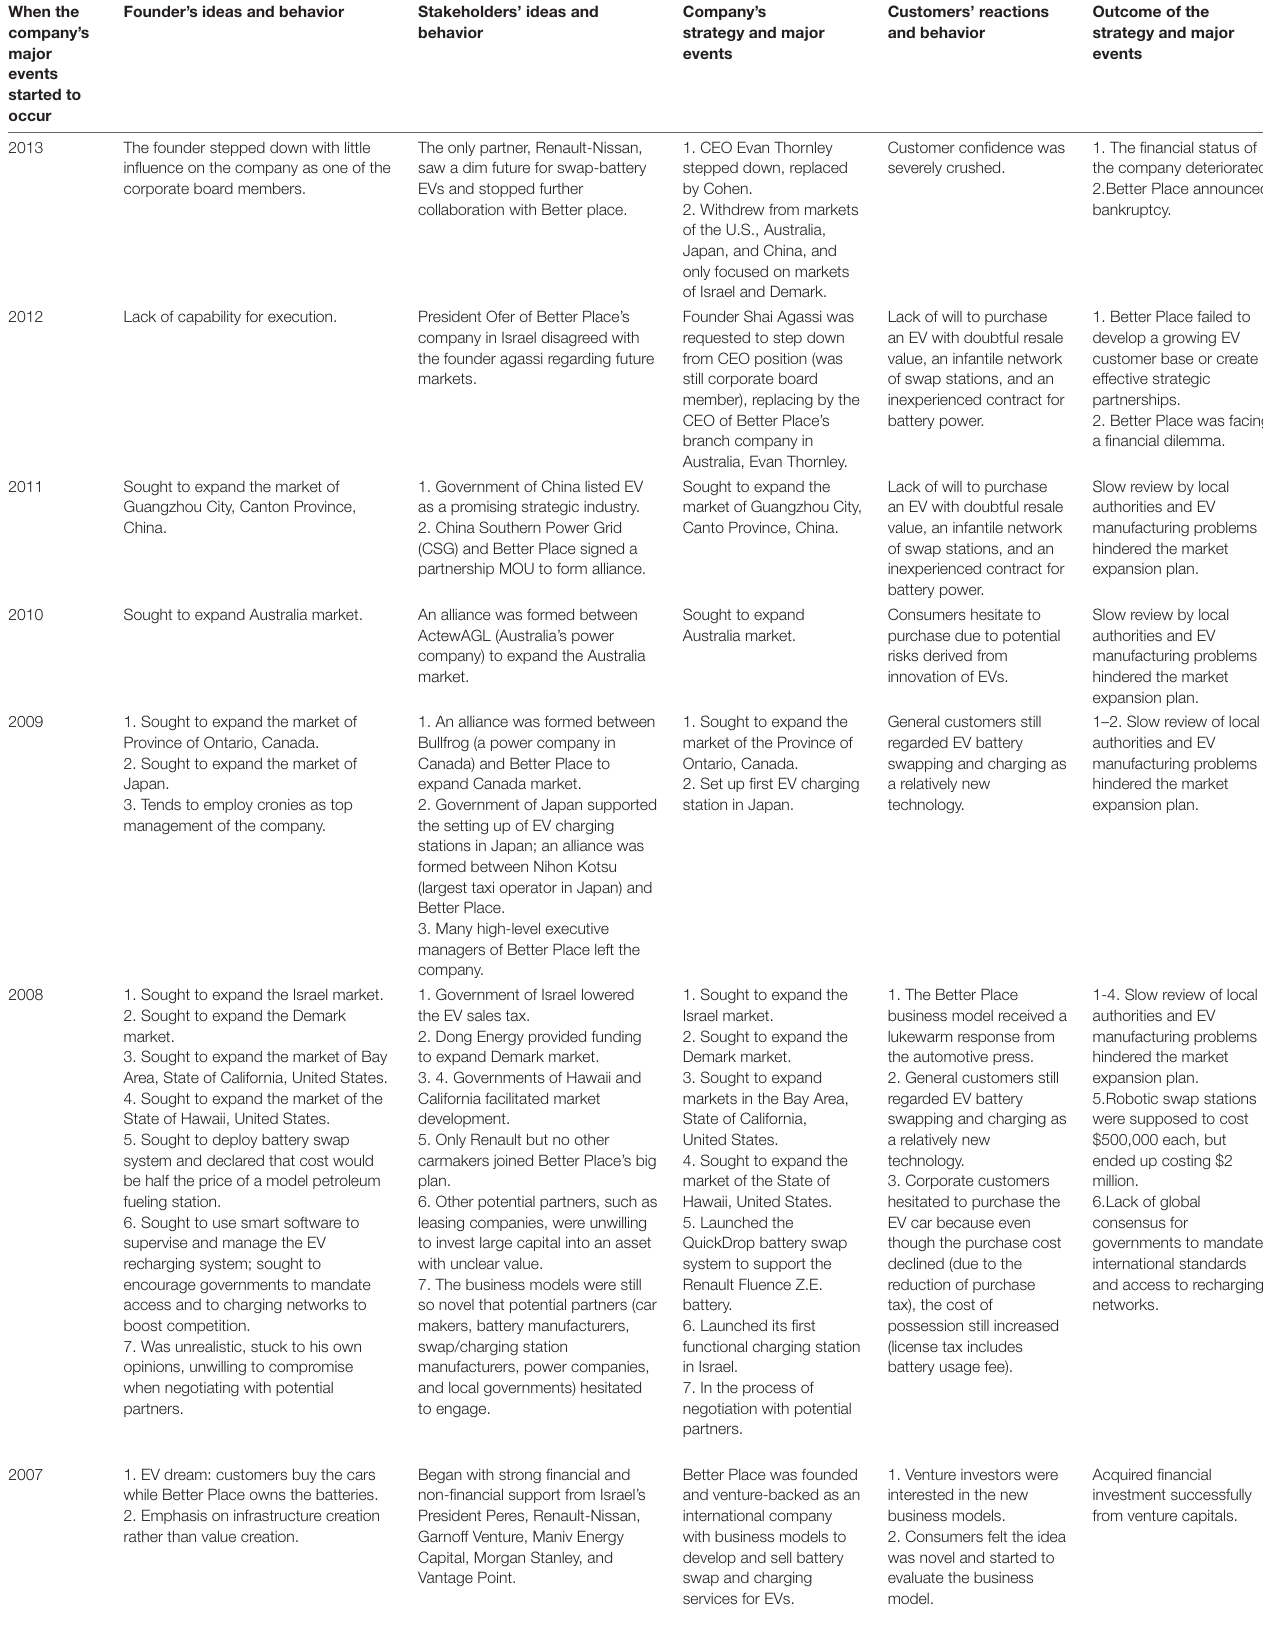
TABLE 2 | Better Place’s time line of issues and